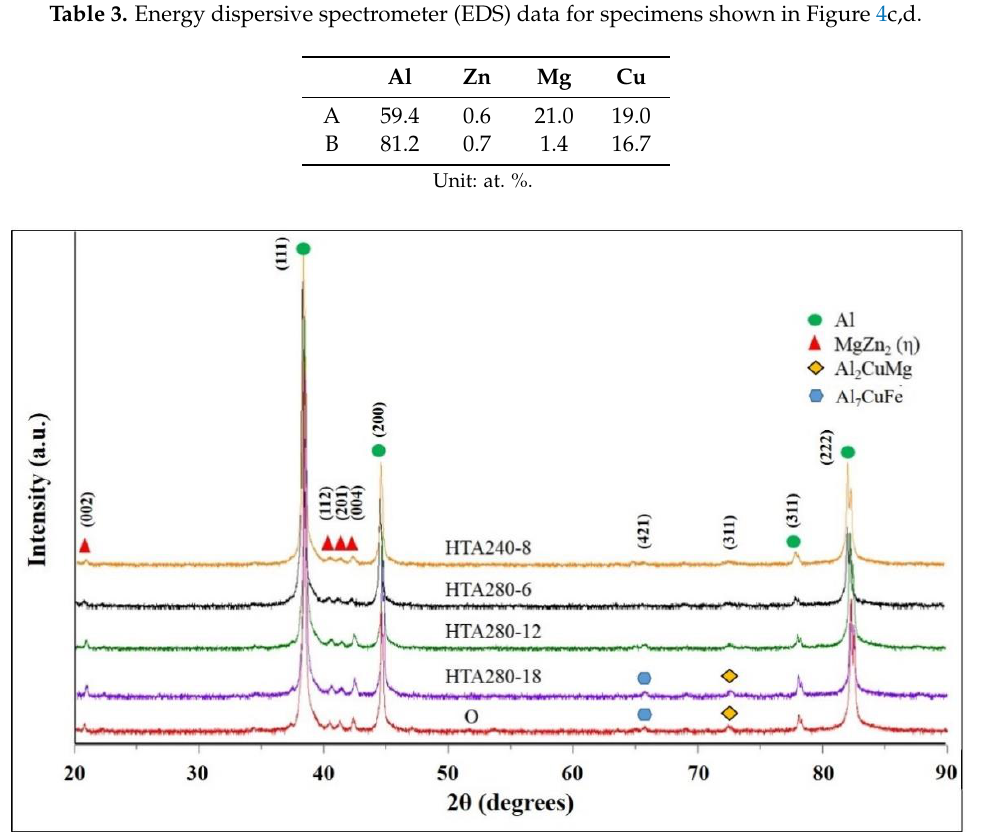
Figure 5. XRD analysis of 7075 Al alloy extruded rod after various PPHTs.